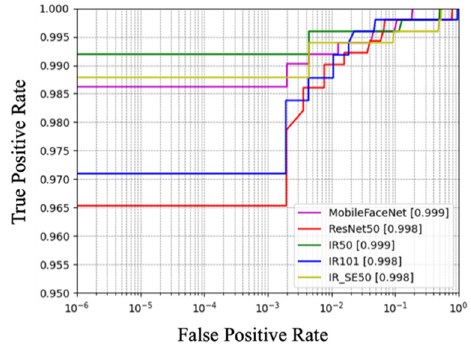
Figure 9. The ROC curve of FPR in the range of 1 × 10 − 6 to 1. Table 1. The value of TAR@FAR = 0.01 (i.e., the probability of correctly identifying matching face pairs when the FAR is close to 0.01) was maintained at more than Table 1. The TAR and corresponding thresholds for different models. Models